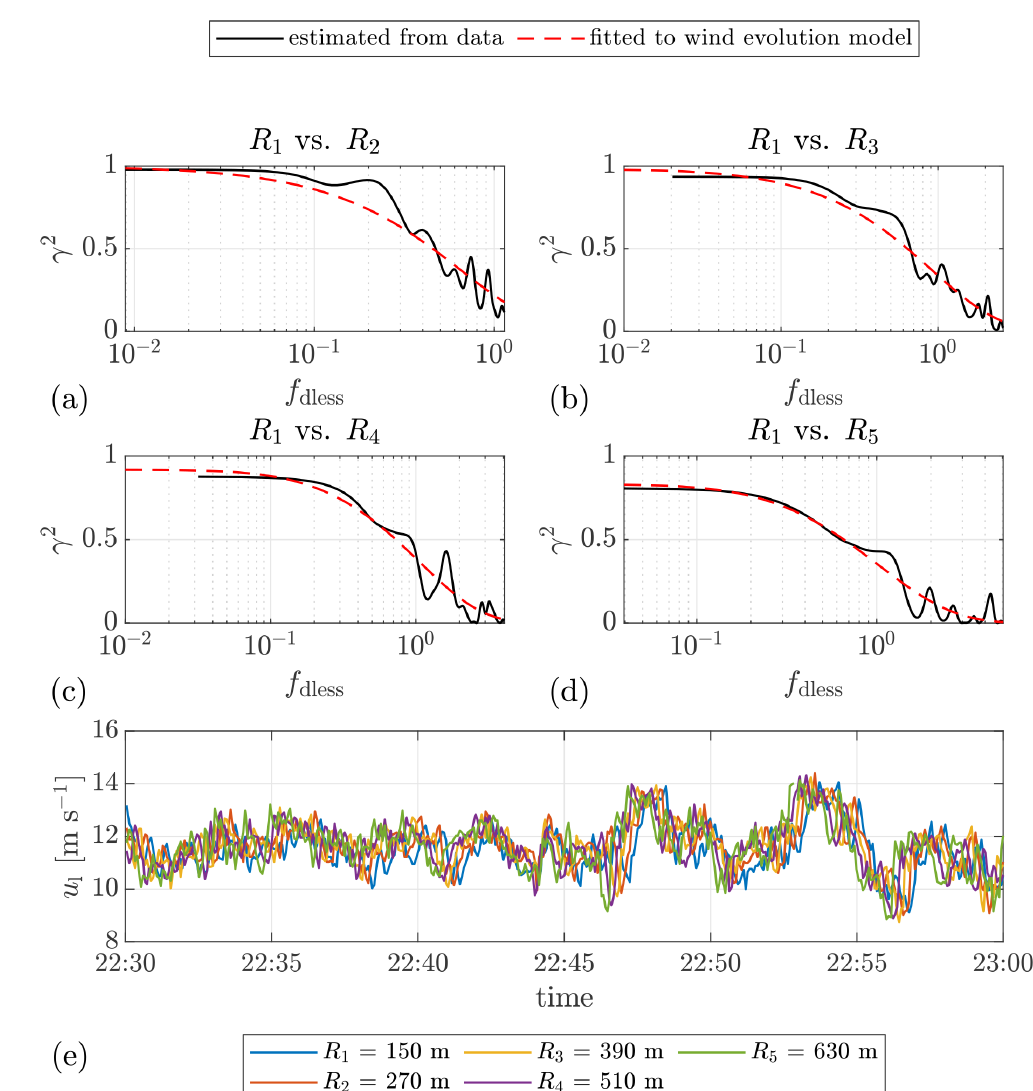
Figure A3. (a–d) Example plots of the estimated coherence between the selected range gates R and the corresponding fitted curves. The corresponding measurement distances are 120, 240, 360, and 480m, respectively. (e) Time series of the lidar wind speed. The mean lidar wind speed is 11.6ms − 1 . Date: 12 June 2019. Data source: